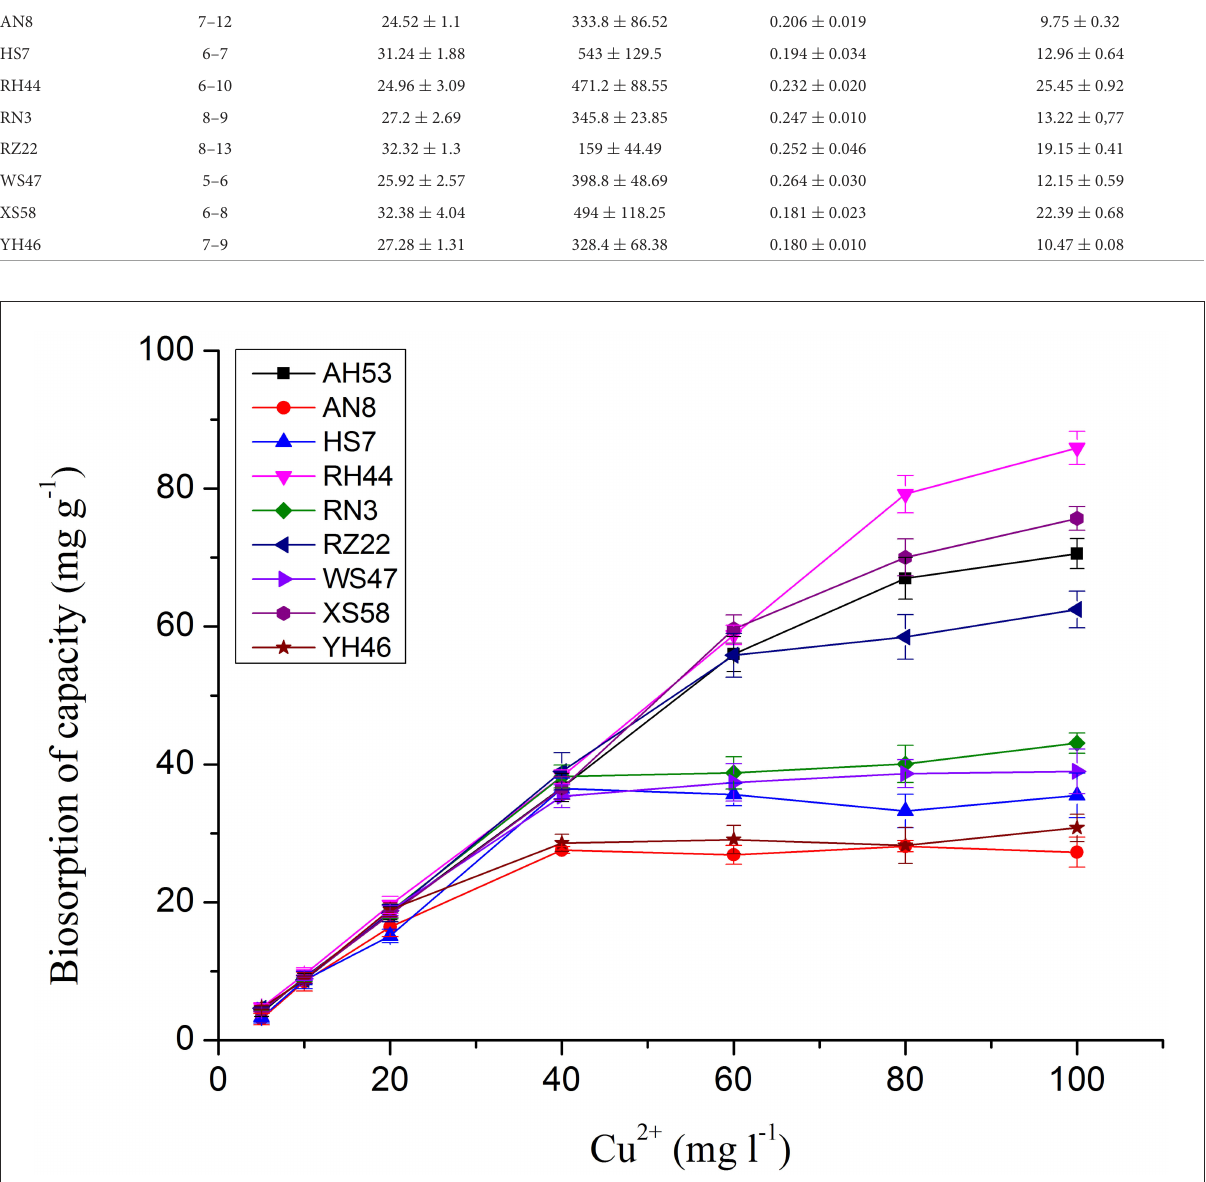
FIGURE1 The effect of initial copper ion concentration on copper ion adsorption by Spirulina biomasses at the optimum pH of 6.0 for 12